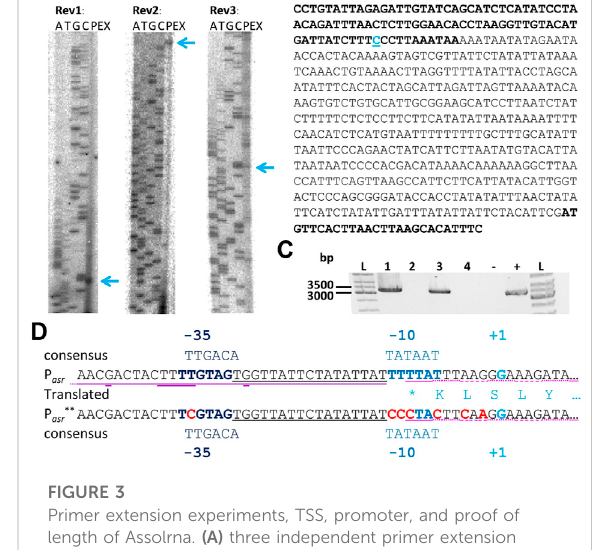
FIGURE 3 Primer extension experiments, TSS, promoter, and proof